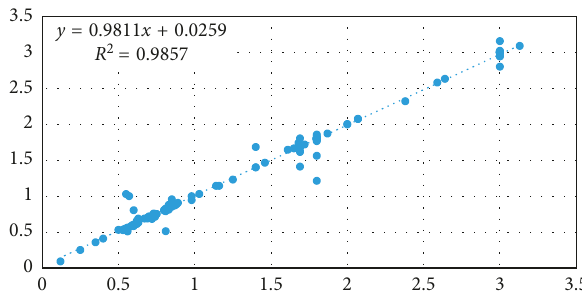
Figure 6: U-opaque prediction using the year of construction and the usable area of the